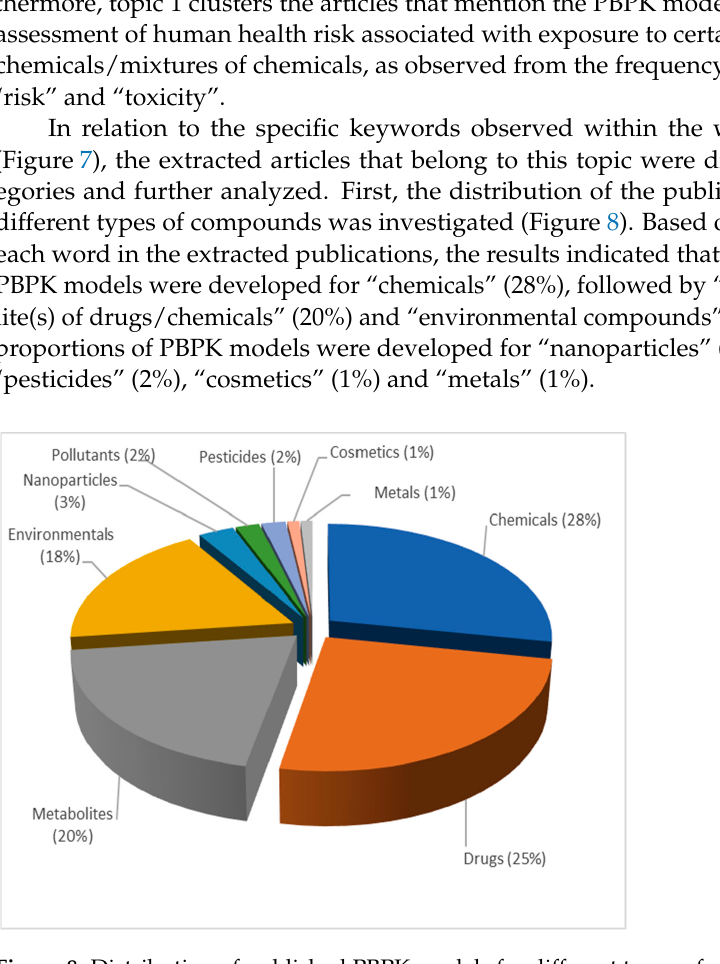
Figure 8. Distribution of published PBPK models for different types of compounds within topic 1, expressed as frequency (%), normalized to 100%.